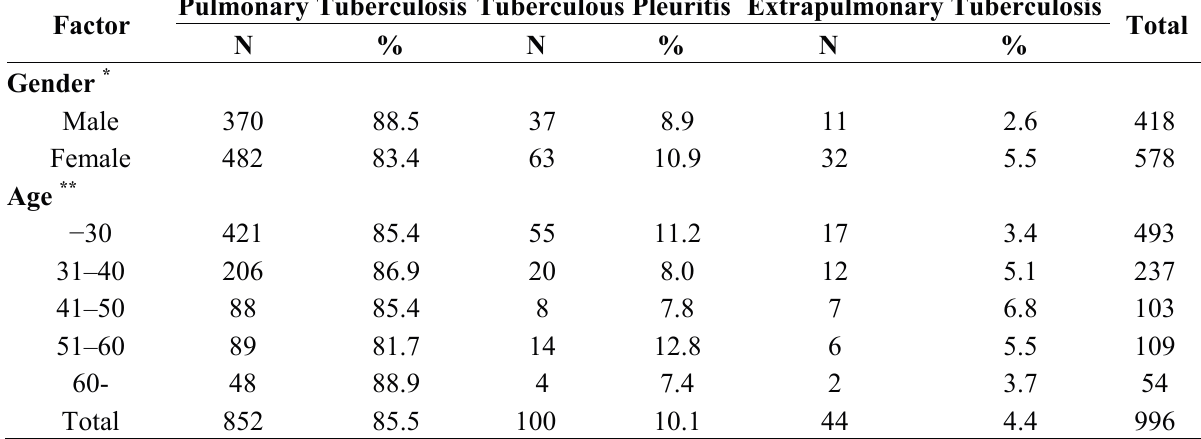
Table 2. Healthcare Worker (HCW) Tuberculosis (TB) Patients with different principal diagnoses.